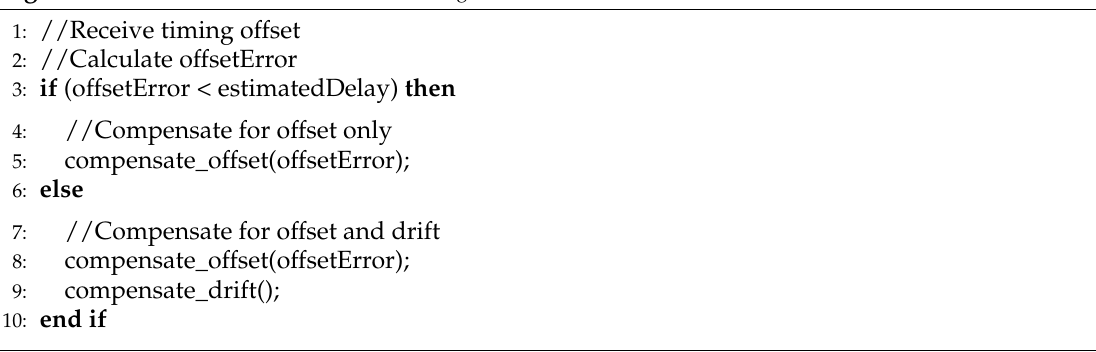
Algorithm 1 Procedure to handle received message in E-FTSP